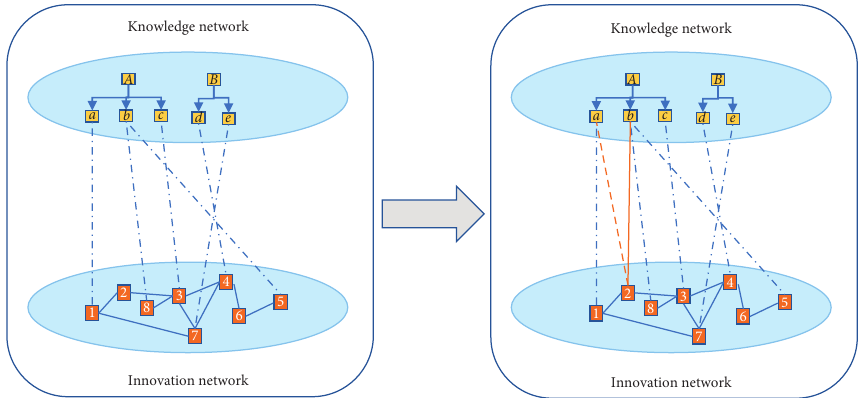
Figure 3: Mechanism of knowledge sharing in multilayer